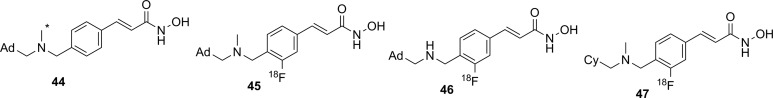
Martinostat (44) and derivatives for imaging of HDACs. *11C. Ad indicates adamantly; Cy, cyclohexyl; HDACs, histone deacetylases.